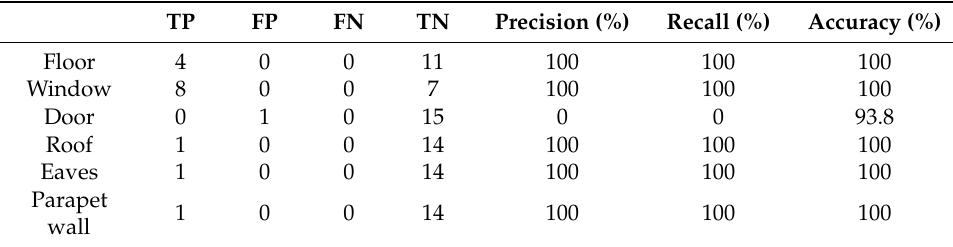
Table 8. Evaluation of semantic recognition for case study